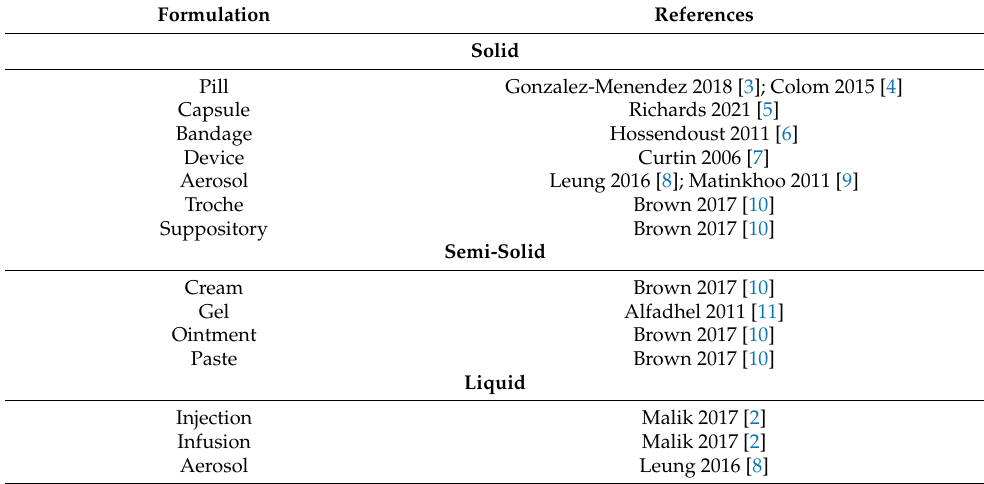
Table 1. Illustration of formulations reported in the literature for phage therapy.